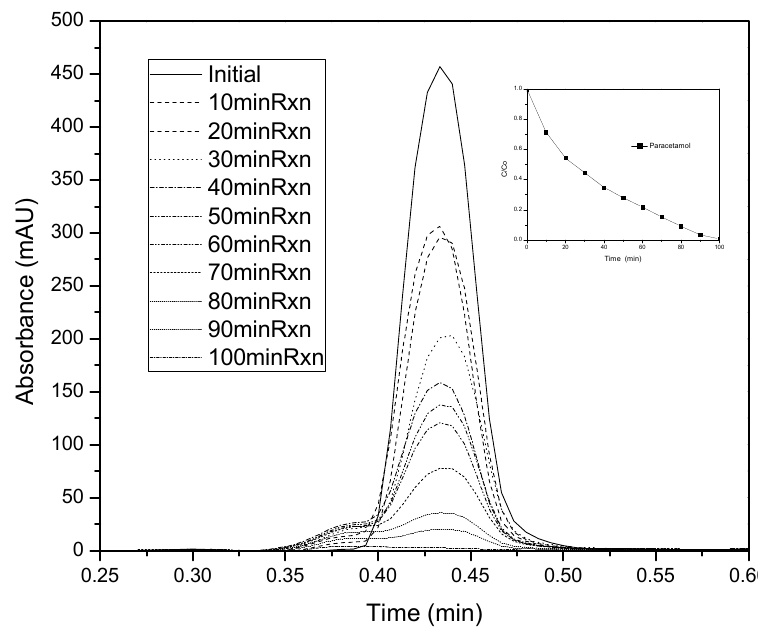
Figure 5. Paracetamol photodegradation kinetics with HPLC data for the samples at pH 6.5.